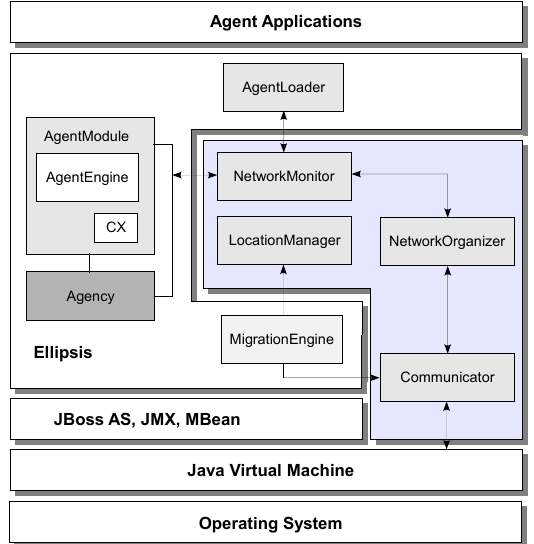
Figure 5. Software Architecture